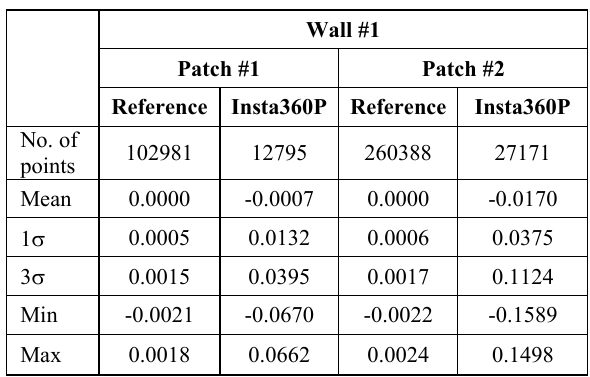
Table 3. Statistical results for surface patches on Wall 1.